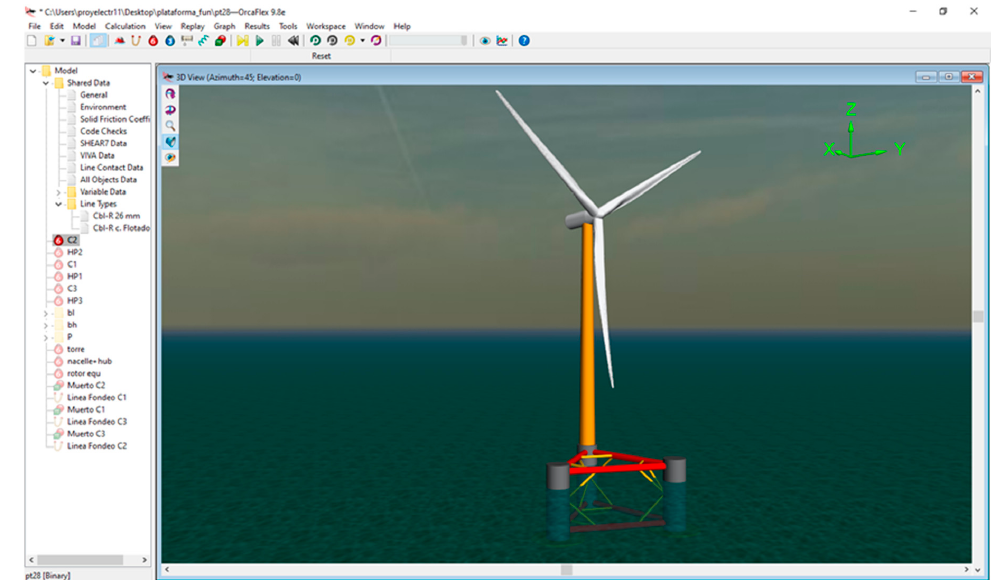
Figure 10. Render view of the Winfloat in